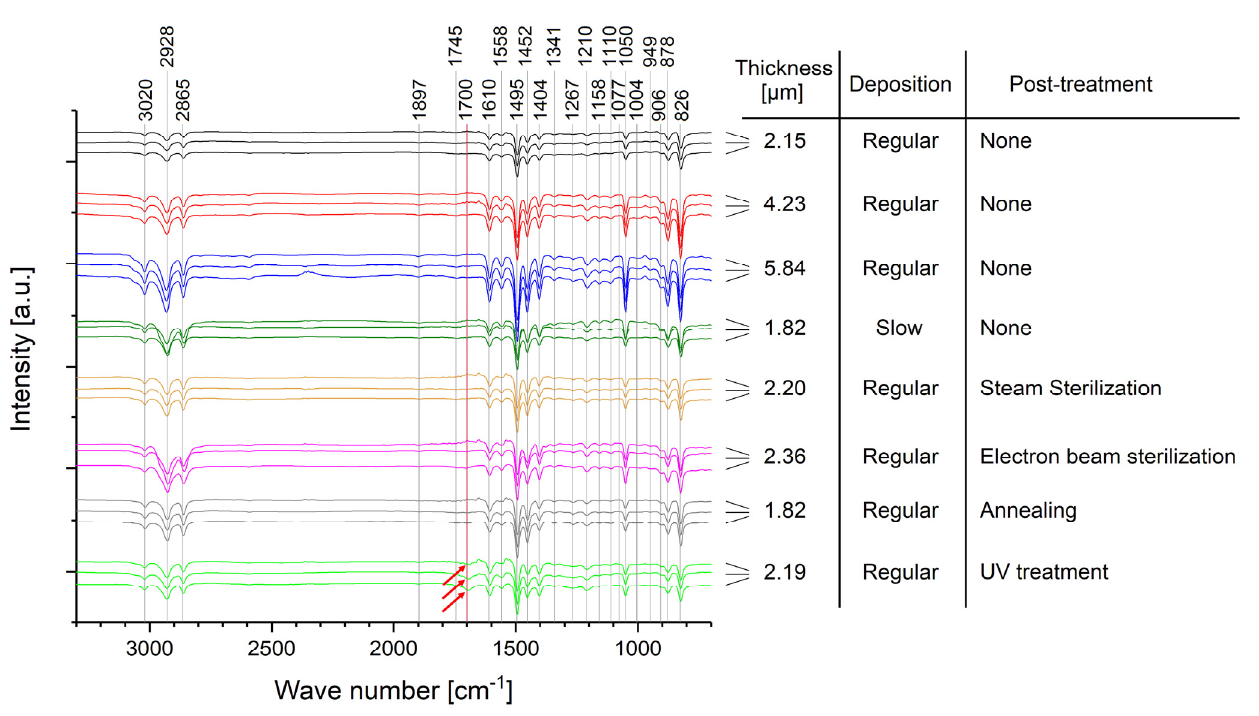
Figure 6. FTIR spectra for the different samples after correction of the sinusoidal overlap. Each sample is represented by three spectra obtained after fabrication (upper) and after a non-accelerated aging time of ~1200 days (middle) and ~1800 days (lower). The red arrows highlight the oxidation peaks measured for the UV post-treated samples.